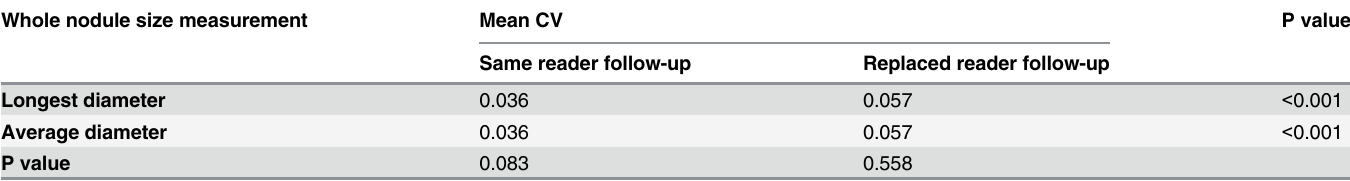
Table 2. Coefficient of variation (CV) comparisons of whole nodule size measurements.